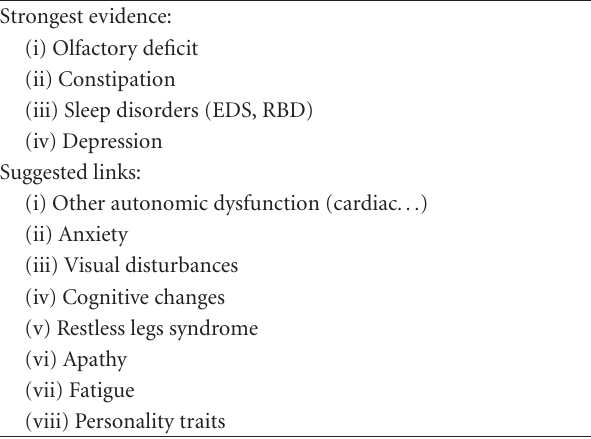
Table 4: Premotor symptoms (adapted from [136]) . Strongest